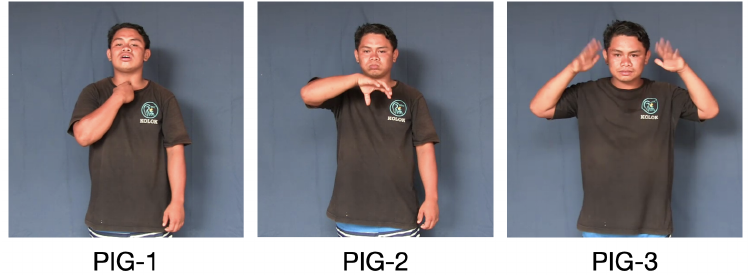
Figure 1. Three variants for pig in Kata Kolok produced in response to a picture description task (Lutzenberger et al. 2021; Mudd et al. 2020). The iconic motivation underlying PIG-1 is how a pig is killed, for PIG-2 is how a pig eats and for PIG-3 is the ears of a pig. It is clear that the cultural context of the Kata Kolok community has shaped lexical preferences, illustrated with iconic signs (i.e., mappings between culturally salient features and forms). For instance, the iconic motivations of PIG-1 and PIG-2 stem from farming practices in the